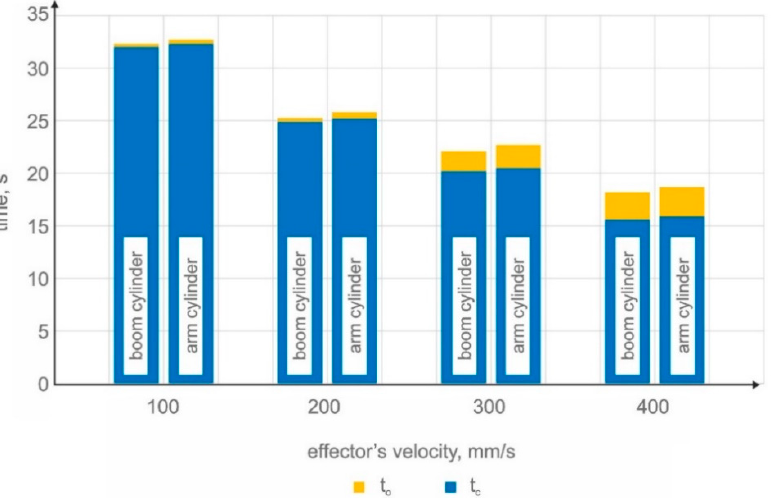
Figure 23. Time t c and t o for different speeds of movement of the effector for the drive system without counterbalance valves.